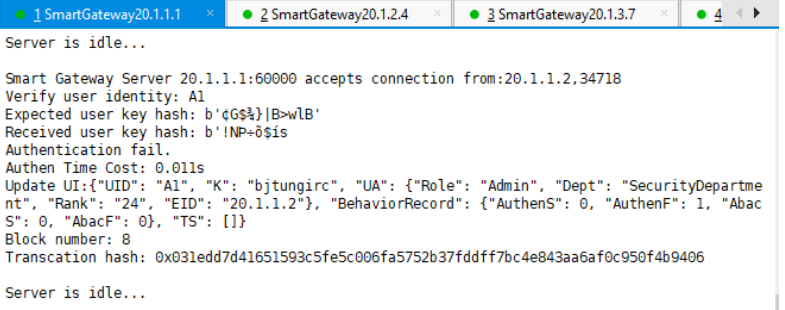
Figure 9. SG A performs access control process and the result is authentication failure.